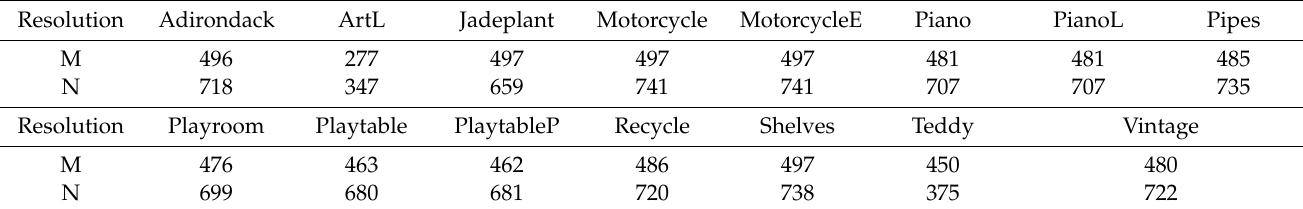
Table 1. Resolution of the images for stereo matching.